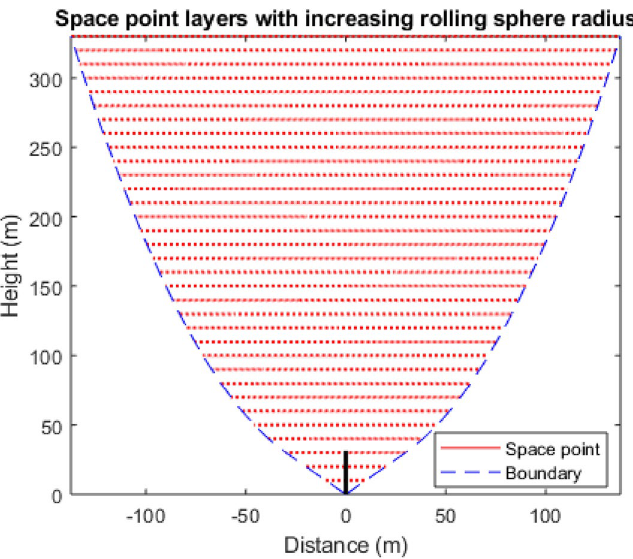
Figure 10. Space point layers and interception boundary around a 30 m high lightning rod.